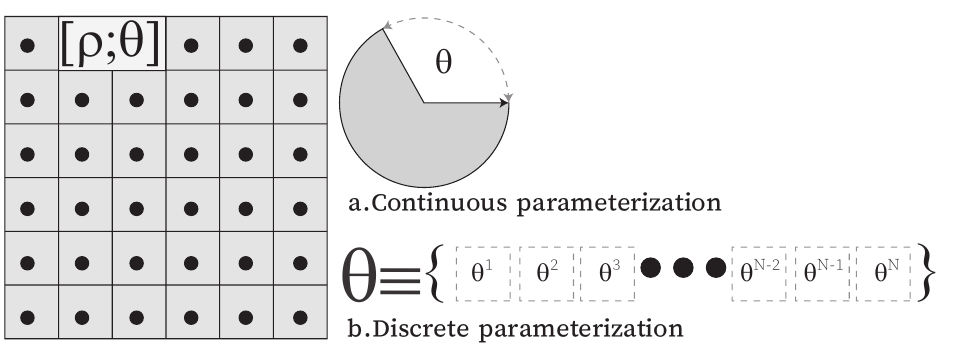
Figure 3. Finite elements are considered design variables in DTO: ( a ) Continuous material orientation; ( b ) Discrete material